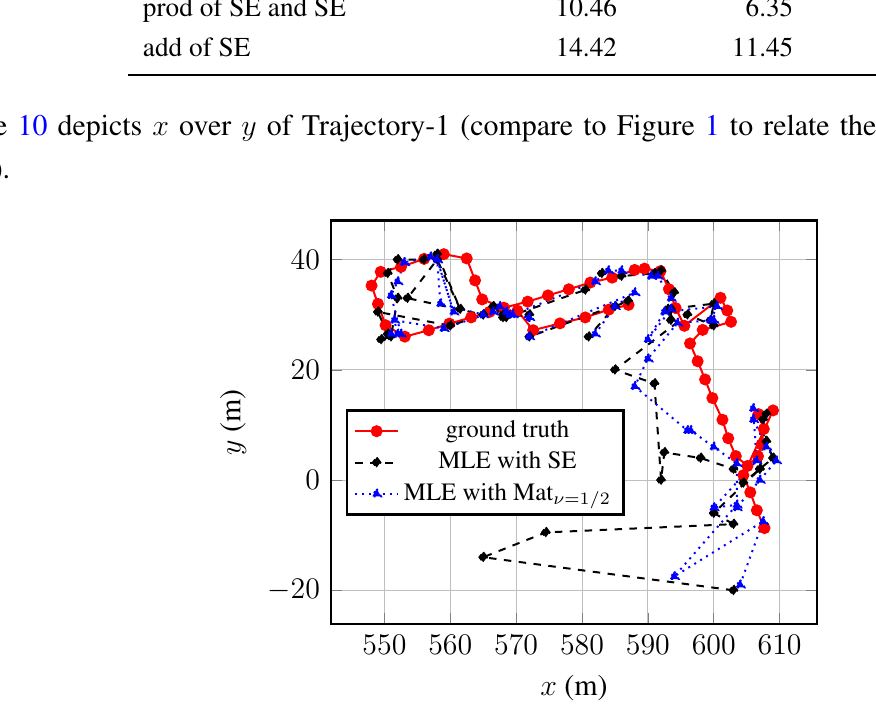
Figure 10. Estimates of Trajectory-1 and the ground truth. The MLEs are based on a Gaussian process model with a constant mean and (1) the squared exponential (SE) or (2) the Matérn class (Mat ) ν =1 / 2